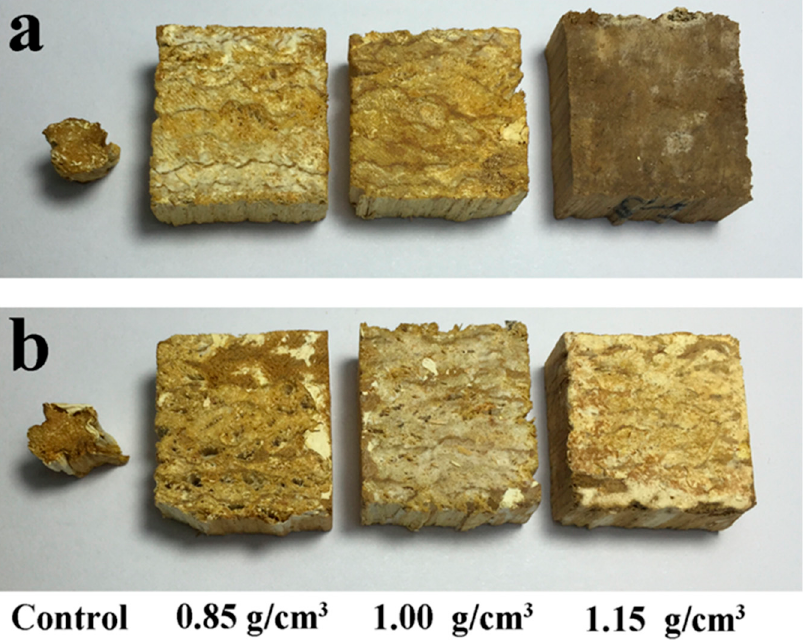
Figure 2. Photographs of wood reference samples (control) and OWMEC samples with different densities (0.85, 1.00, and 1.15 g/cm 3 ) after 12 weeks of incubation. ( a ): T. versicolor decay; ( b ): G. trabeum decay .